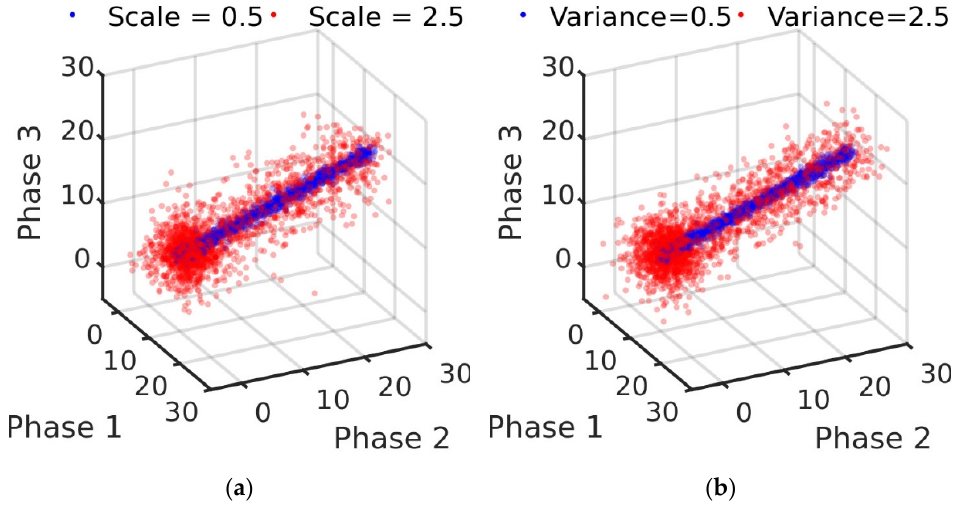
Figure 4. Vector sets of the time series in a phase space ( L = 3) under ( a ) Gaussian noise and ( b ) Laplacian noise. Both distributions are spindle-shaped, indicating that ionospheric anomalies, denoted by the sharp head part, can be easily distinguished from the normal points denoted by the thick middle part.